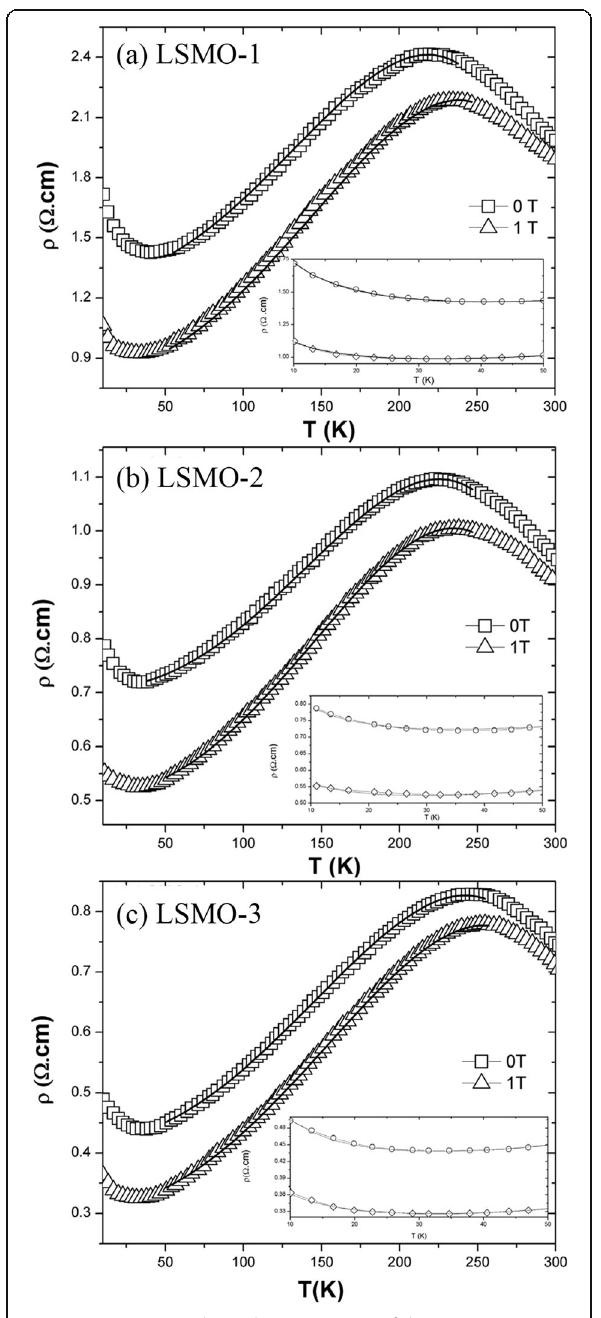
Fig. 25 Temperature dependence resistivity of the La 0.7 Sr 0.3 MnO 3 (LSMO) nanoparticles with zero field and 1 T fitted by using ρ T 2 + ρ T 4.5 . a LSMO-1 particles (average size of 20 nm), ρ ( T ) = ρ 0 + 2 4.5 b LSMO-2 particles (average size of 23 nm), and c LSMO-3 particles (average size of 26 nm). Inset shows the fitting of the resistivity data in the low temperature region by using ρ L ¼ ρ 0 − ρ s ln T þ ρ e T 1 2 þ ρ p T 5 . Reproduced with permission of [216]